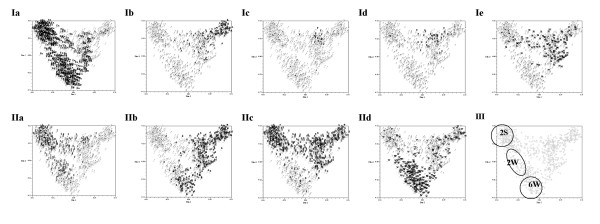
Principal Coordinate Analysis of the global population of 953 barley accessions. Each scatterplot presents clustering of the complete set of 953 accessions with highlighted accessions (I) originating from one geographic region, or (II) possessing a defined agronomic trait. Ia – Europe (Eu), Ib – Asia (A), Ic – Africa (F), Id – Near East (E), Ie – America (M), IIa – 2-rowed accessions (2), IIb – 6-rowed accessions (6), IIc – spring accessions (S), IId – winter accessions (W). III – Distinct clusters of European 2-rowed spring accessions (2S), 2-rowed winter accessions (2W), and 6-rowed winter accessions (6W).